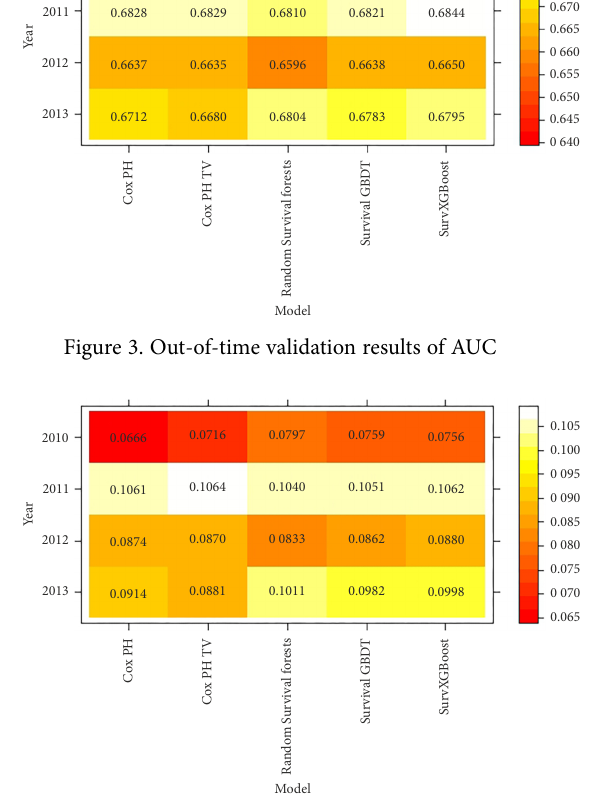
Figure 4. Out-of-time validation results of H